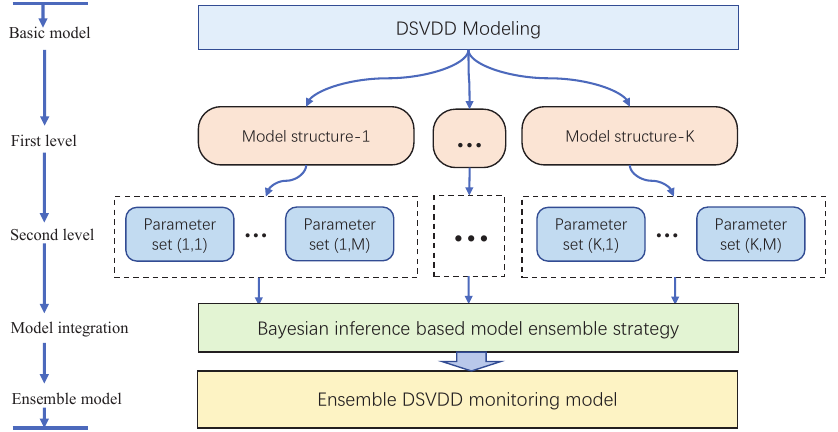
Figure 3. Ensemble Deep SVDD